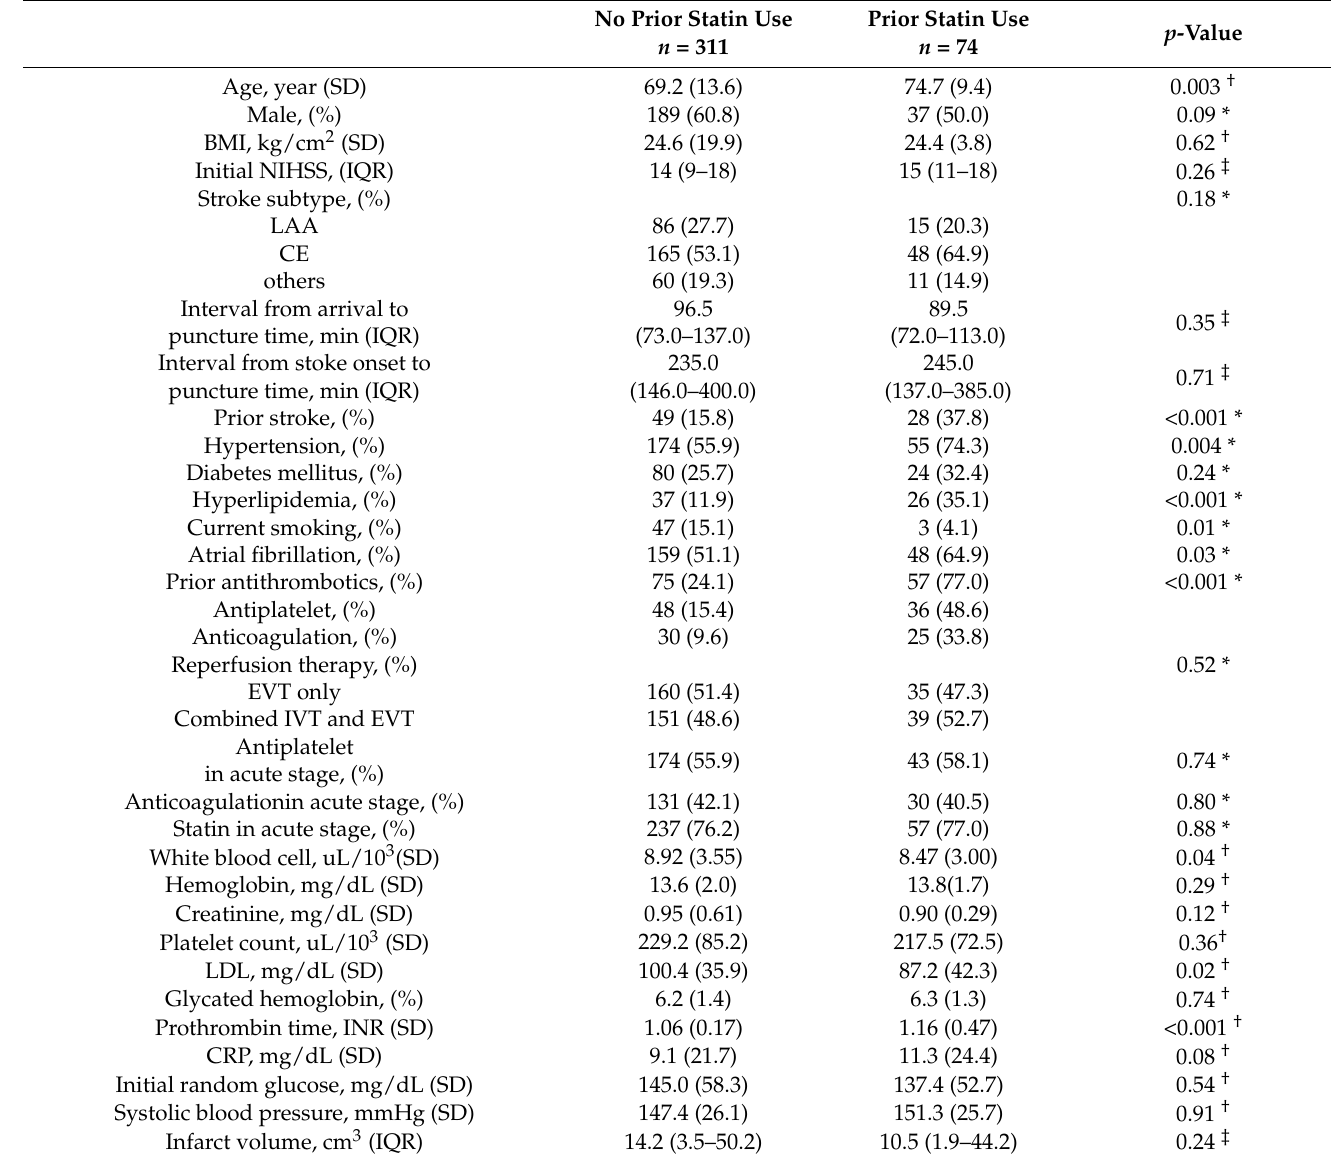
Table 1. Baseline characteristics according to prior statin use and no prior statin